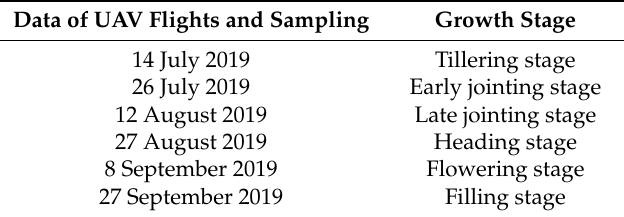
Table 3. Data of the UAV flights and sampling dates in the corresponding rice growth stages.